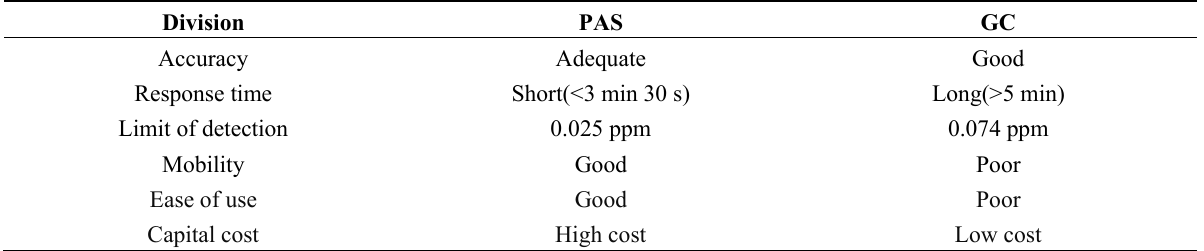
Table 5. Analysis of the exhaust gas concentrations with PAS and